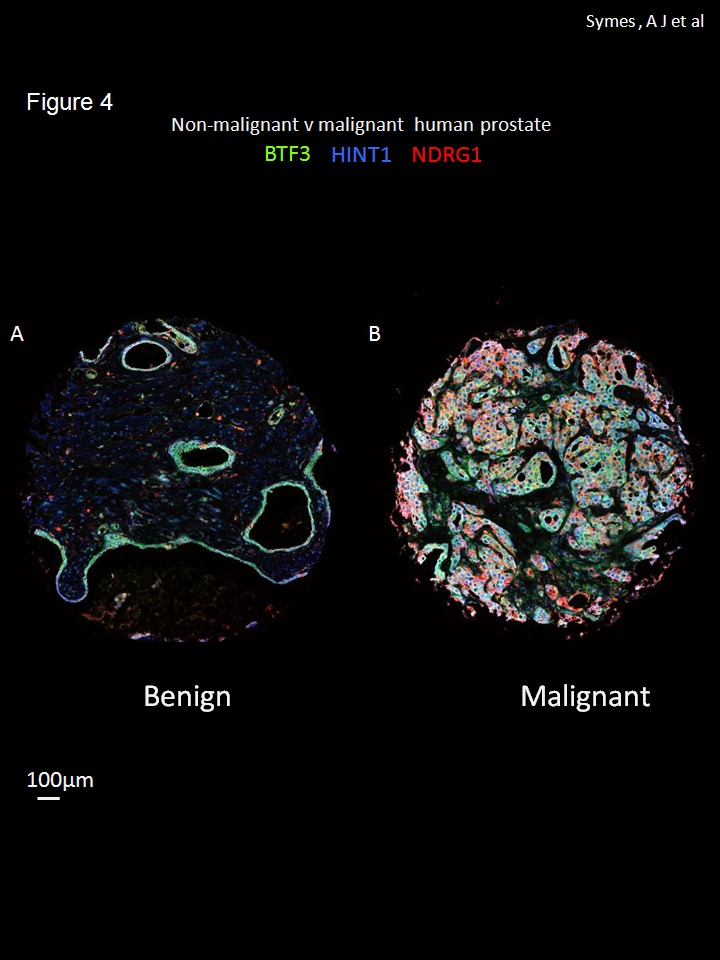
Multi-labeled immunofluorescence for BTF3, HINT1 and NDRG1.Co-expression of three proteins BTF3 (FITC-green), HINT1 (Cy3- blue) and NDRG1 (Cy5-red) in non-malignant (A) and malignant prostate tissue cores (B); images are representative tissue cores from the tissue array with over 200 samples. The three antibodies were incubated simultaneously and labeled with three Cy5 –red different fluorophores using Bond automated staining system. Whole tissue cores were imaged using a Leica confocal system and 4x4 tiling at exactly the same settings for comparison. Images were zoomed 3x using digital zoom in ImageJ. Scale bar =100µm.